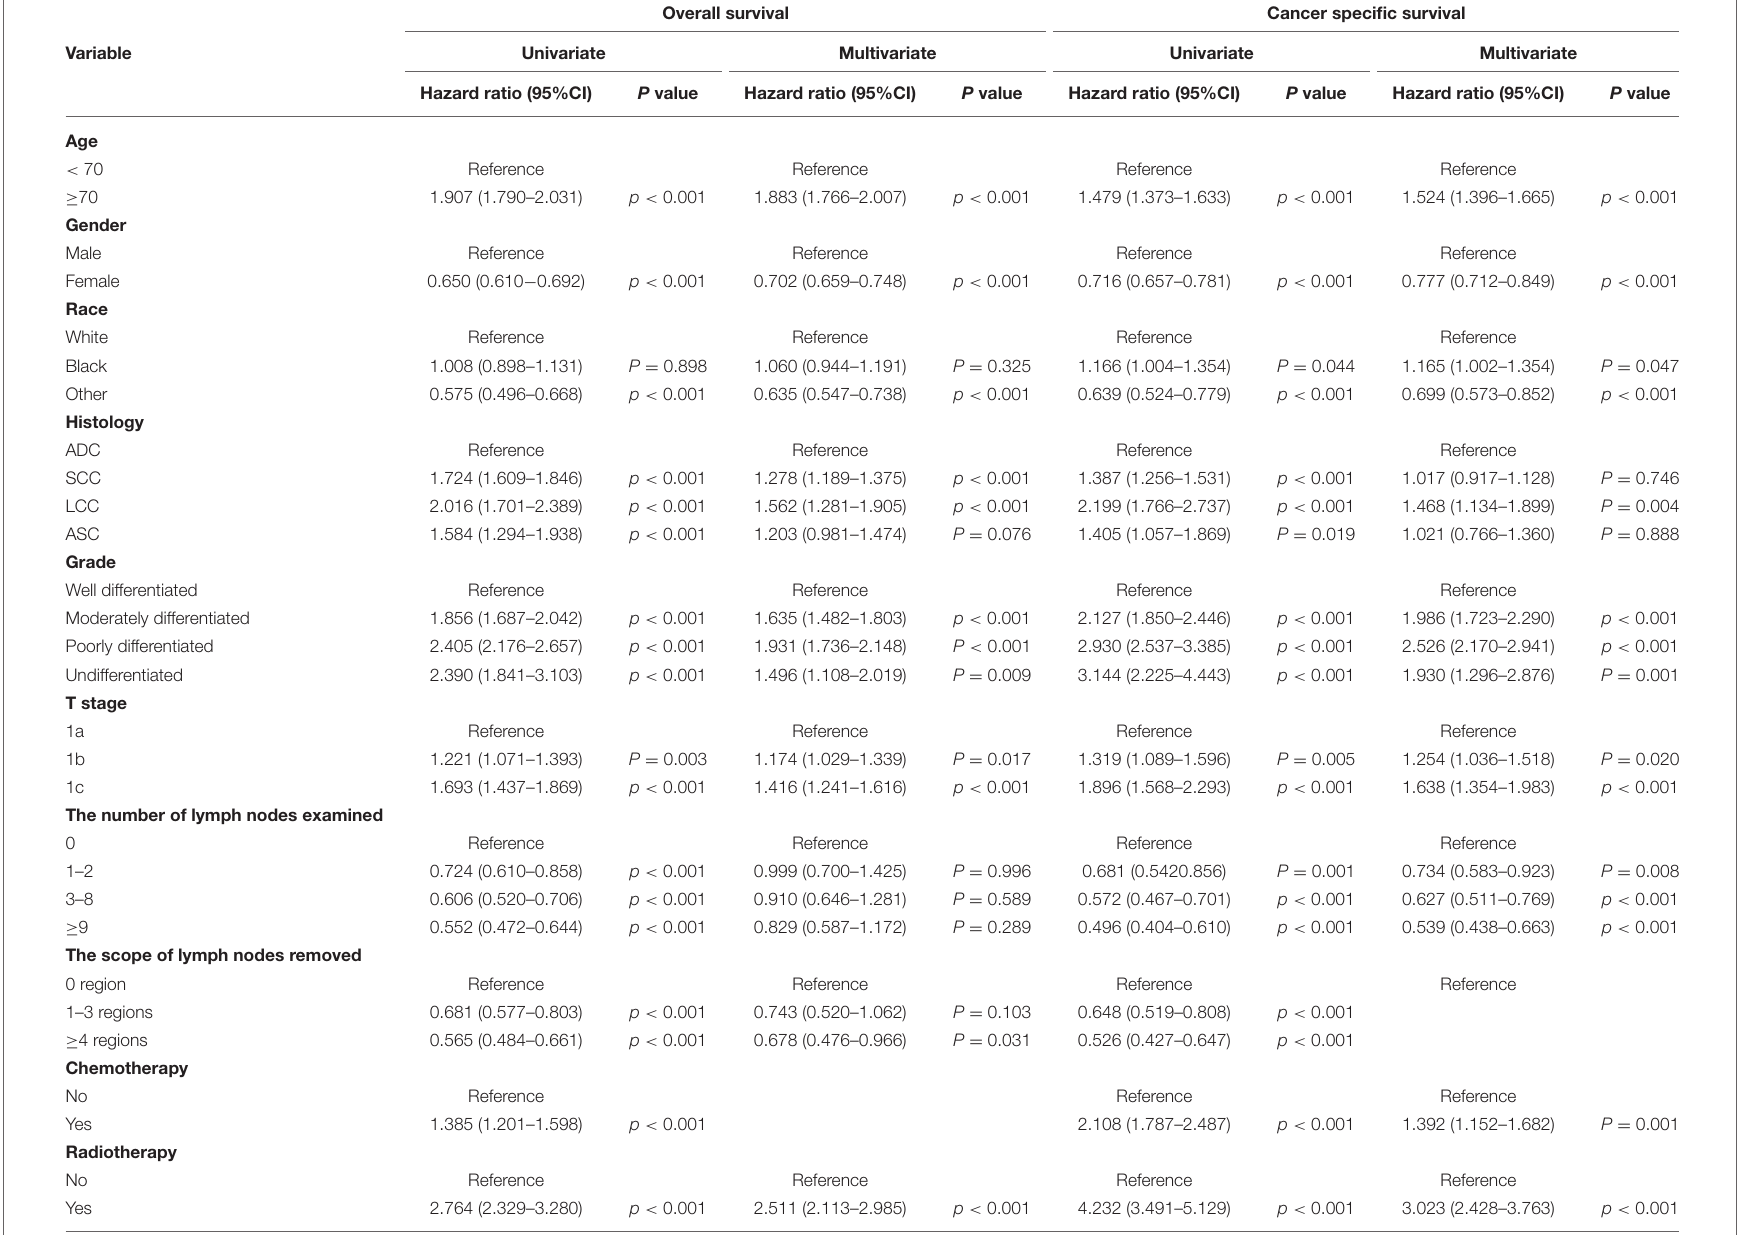
TABLE 3 | Univariate and multivariate analysis of overall survival and cancer-specific